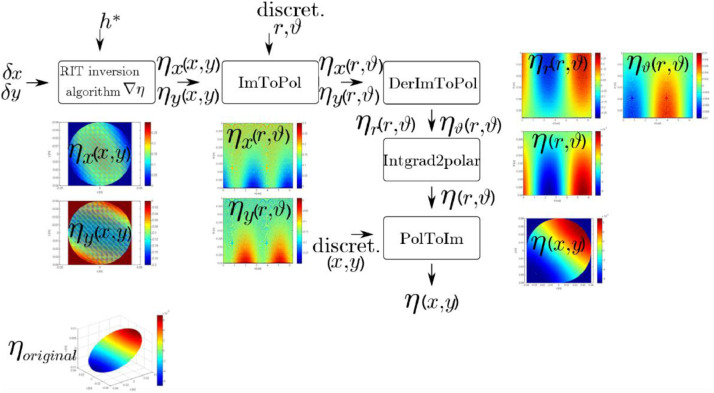
Flowchart of the RIT post-processing methodology for liquid/gas interface reconstruction [3].